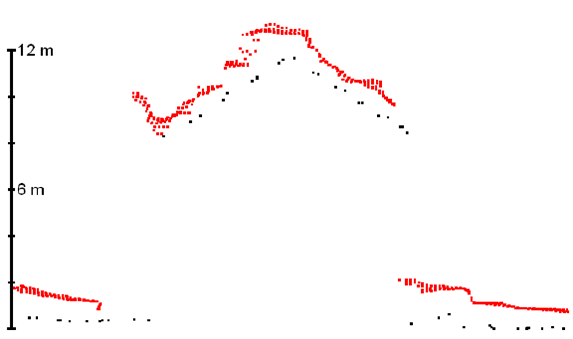
Figure 4. Profile of the reference ALS point cloud (black) and IM point cloud with offset +1 m (red, MATCH-T output) The results of processing the stereo-pairs are point clouds representing a digital surface model (DSM). Point clouds are automatically coloured (software version 5.4 and higher) during generation process. Colourization is based on the input false colour images. This ensures spatial consistency between